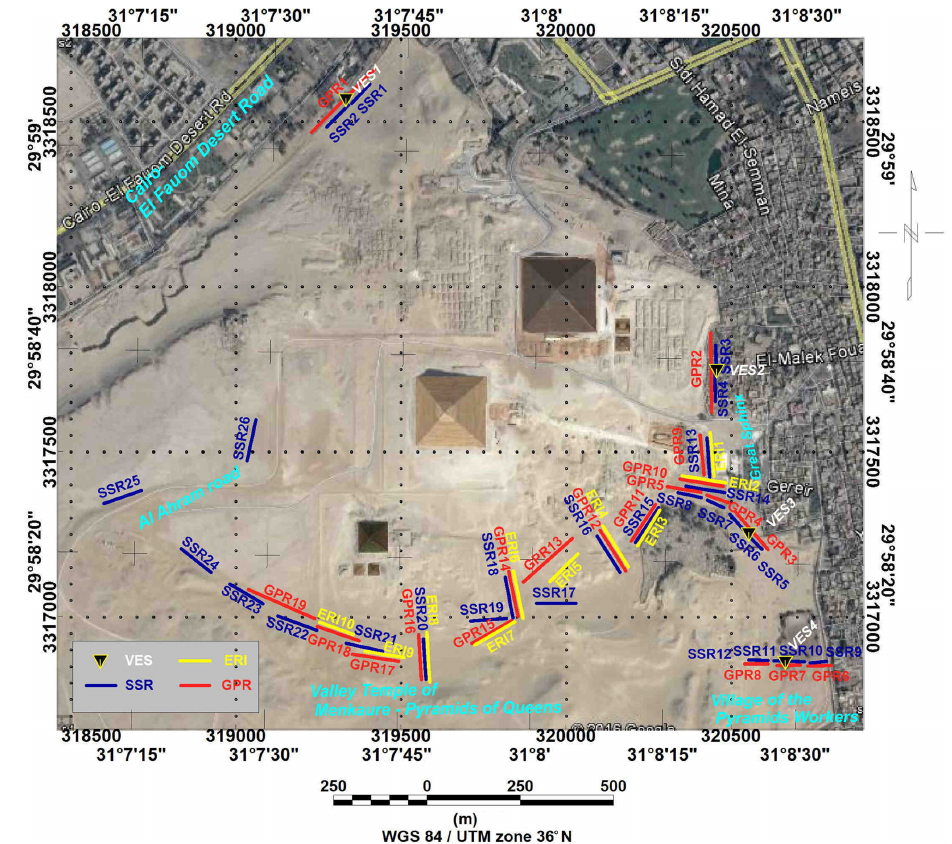
Figure 4. Locations for the profiles and techniques used along the different parts of the Giza Plateau. Table 1. Main characteristics of ERI